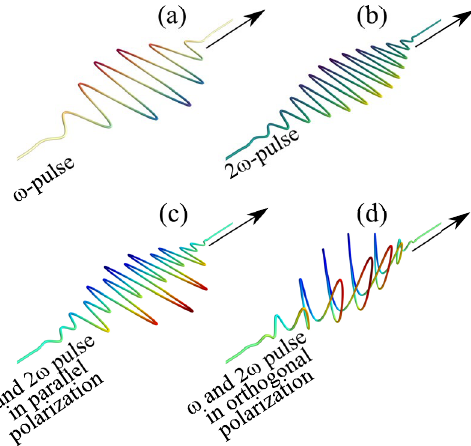
Figure 2. Graphical presentation of the two-pulse configuration which are used in the simulations. ( a ) Representation of pulse with fundamental wavelength (800 nm) pulse. ( b ) Typical second harmonic (2 ω ) pulse. The electric field of the combined two-color ( ω − 2 ω ) driver ( c ) when ω and 2 ω have parallel polarization, ( d ) when ω and 2 ω have orthogonal polarization with no delay between the two pulses.